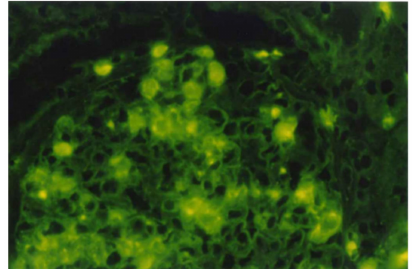
Figure 6. Immunofluorescence staining with rabbit anti-NAPlr antibody in glomeruli from a PSAGN patient (10 days after onset) revealed glomerular NAPlr deposition mainly on the mesangium, the endocapillary side of GBM, and infiltrating neutrophils in a ring-like granular pattern. Original magnification: × 400. GBM: glomerular basement membrane, NAPlr: nephritis-associated plasmin receptor, PSAGN: post-streptococcal acute glomerulonephritis. This photograph is cited from a previously published report